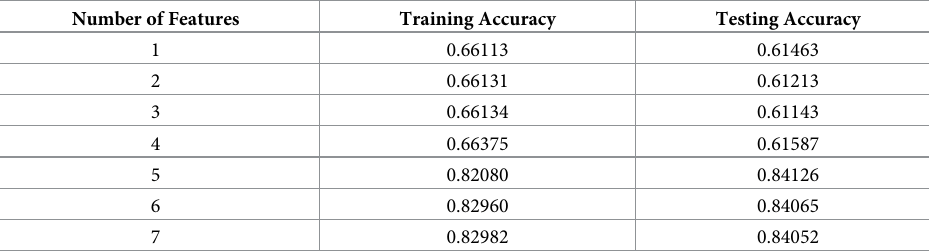
Table 3. Training and testing accuracy with features for linear